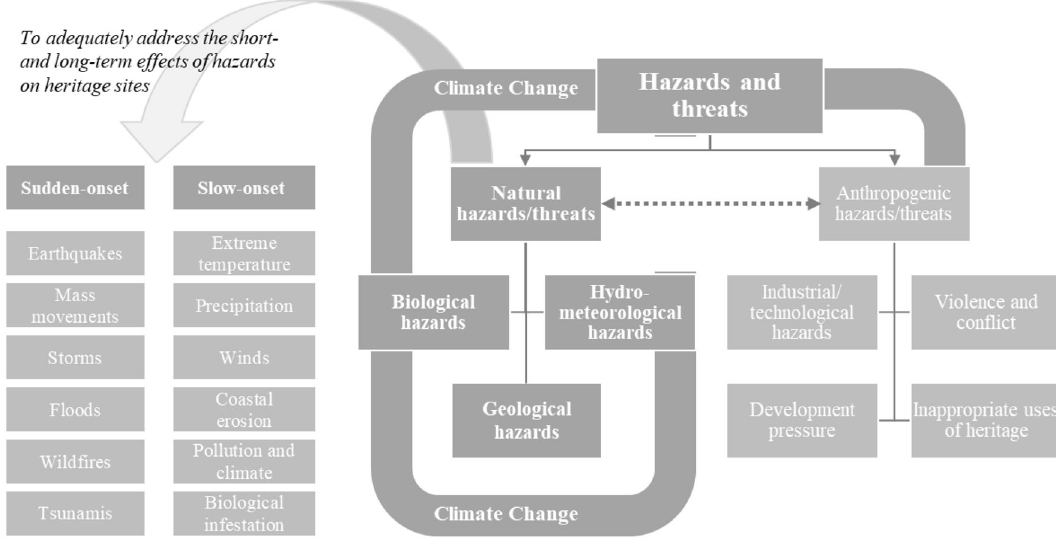
Fig. 1 Classification of natural (or socio-natural) hazards that may affect cultural